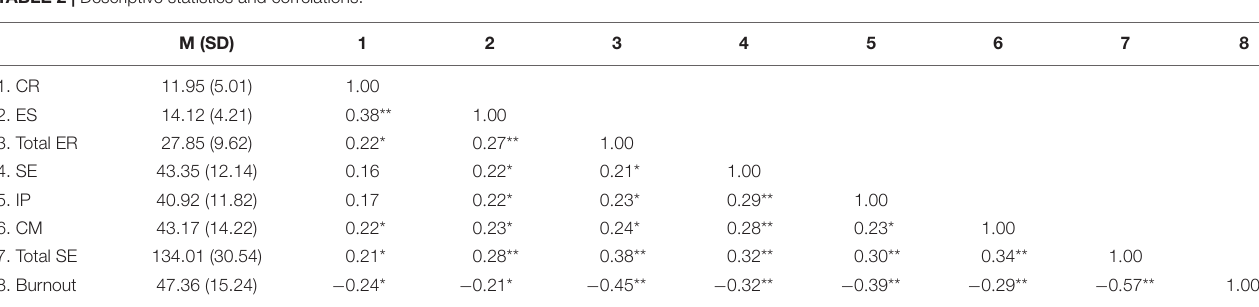
TABLE 2 | Descriptive statistics and